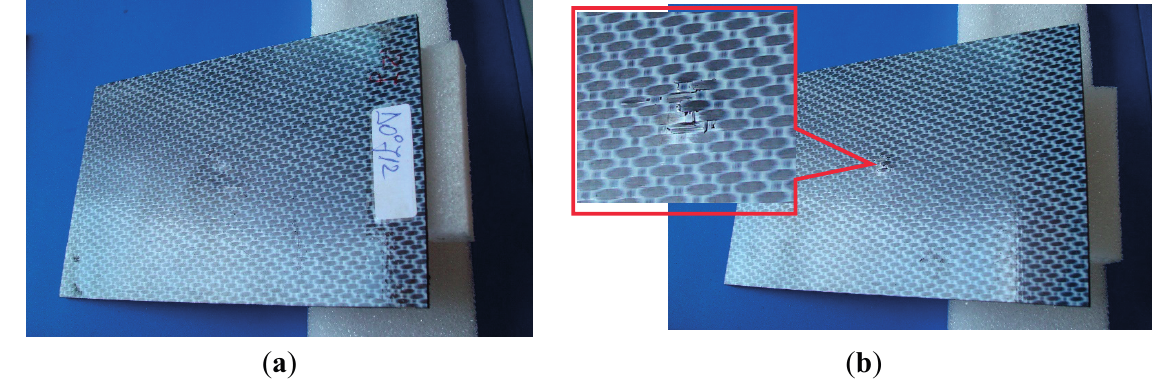
Figure 7. Sample impacted with 12 J energy: ( a ) front side; ( b ) back side—inset: breaking of